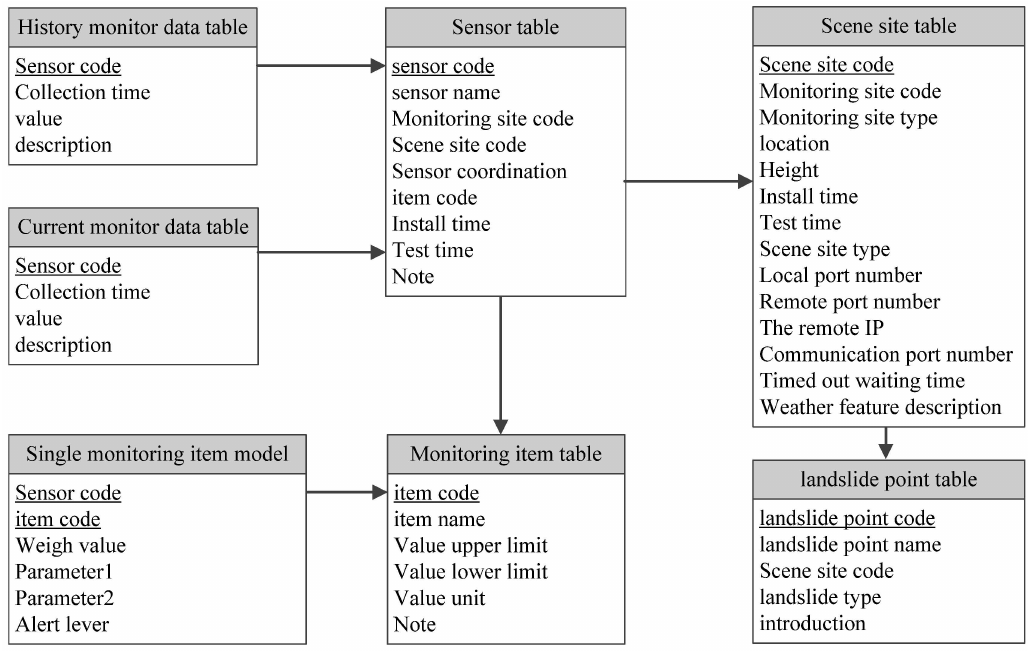
Figure 4. Entity Relationship Diagram of real-time monitoring data model.